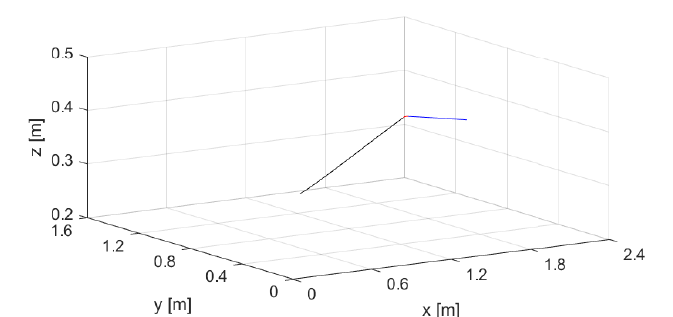
Figure 10. Three-dimensional representation of the end-effector trajectory: in blu,e the nominal trajectory before failure, in red, the connecting path and in black, the straight line path.